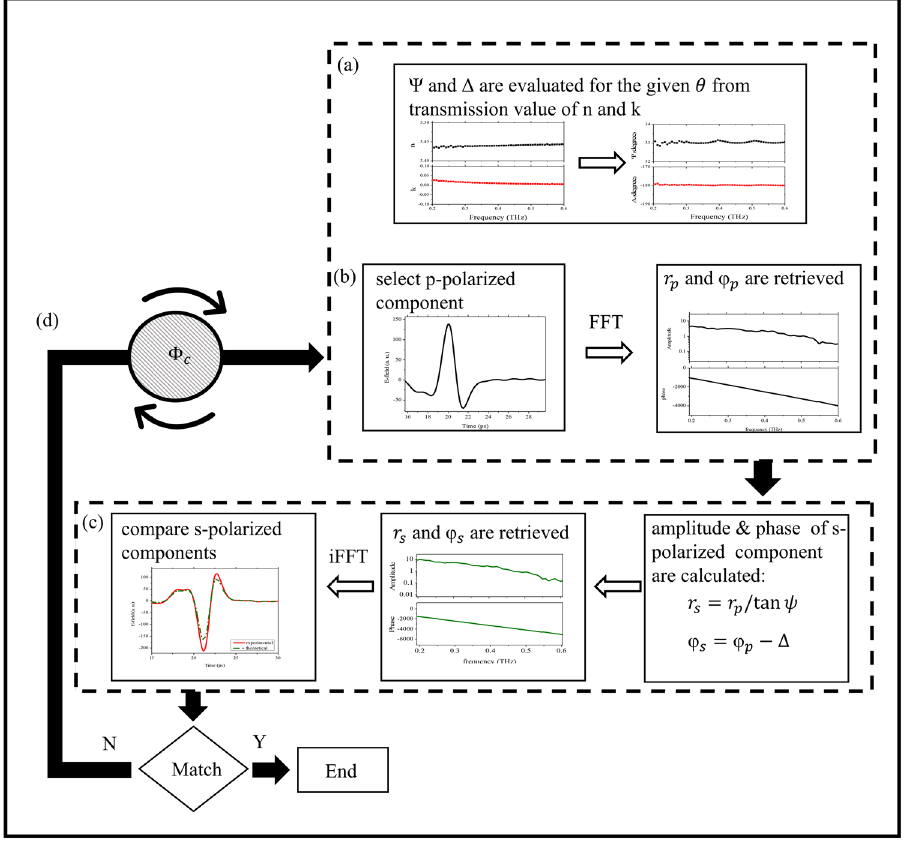
Figure 3. Flowchart of the ellipsometer calibration